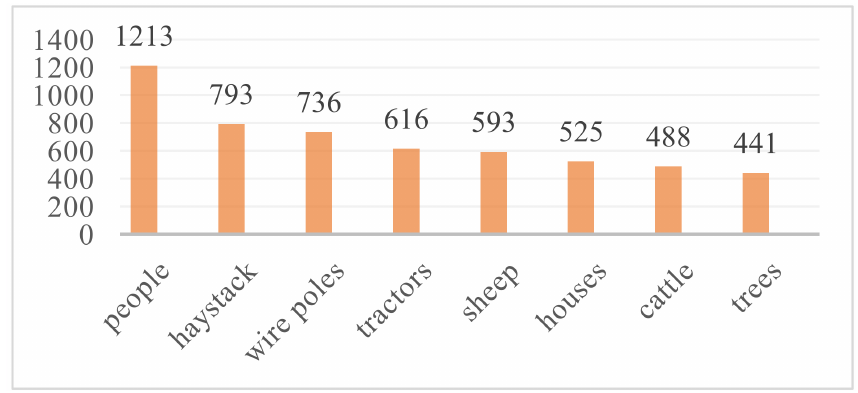
Figure 2. Number of labeling boxes for each type of farmland